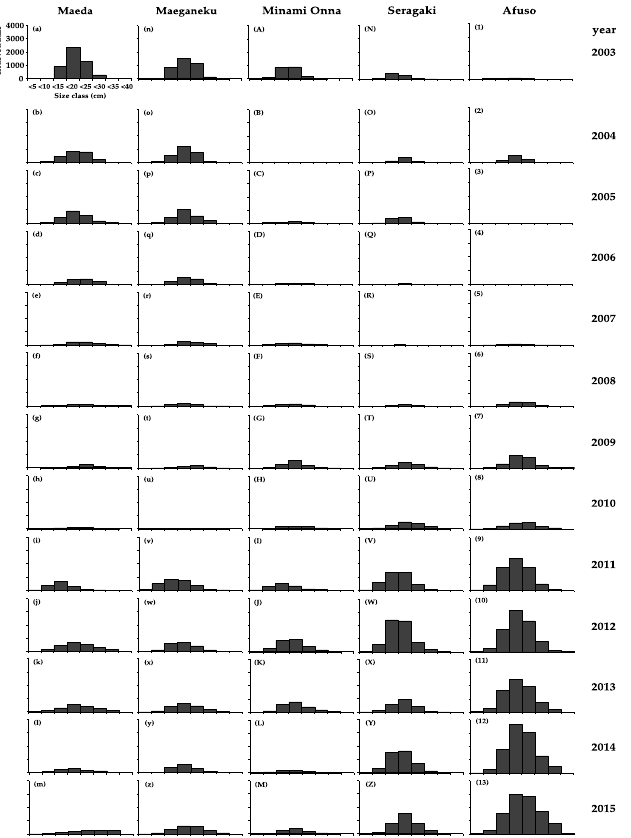
Figure 2. Size-frequency distributions of Acanthaster cf. solaris for five sectors along the Onna Coast, Okinawa, Japan, over 13 years. ( a )–( m ), Maeda; ( n )–( z ), Maeganeku, ( A )–( M ), Minami Onna; ( N )–( Z ), Seragaki, ( 1 )–( 13 ), Afuso.